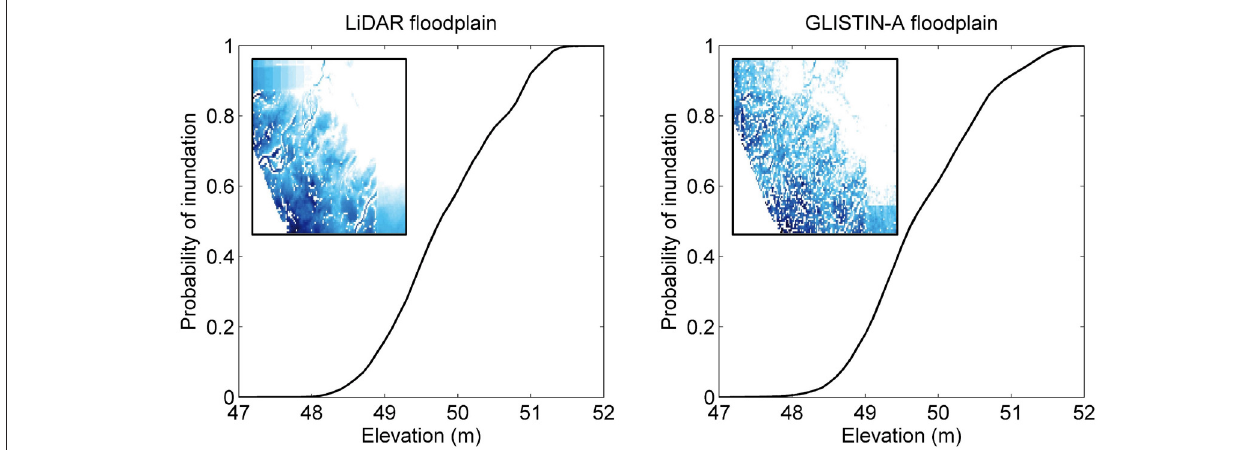
FIGURE 6 | Plot showing the cumulative distribution function of floodplain height profile for both the LiDAR and InSAR DEMs. The small insets show the area inundated to a specific floodplain height for the region inside the lower left rectangle in Figure 4A